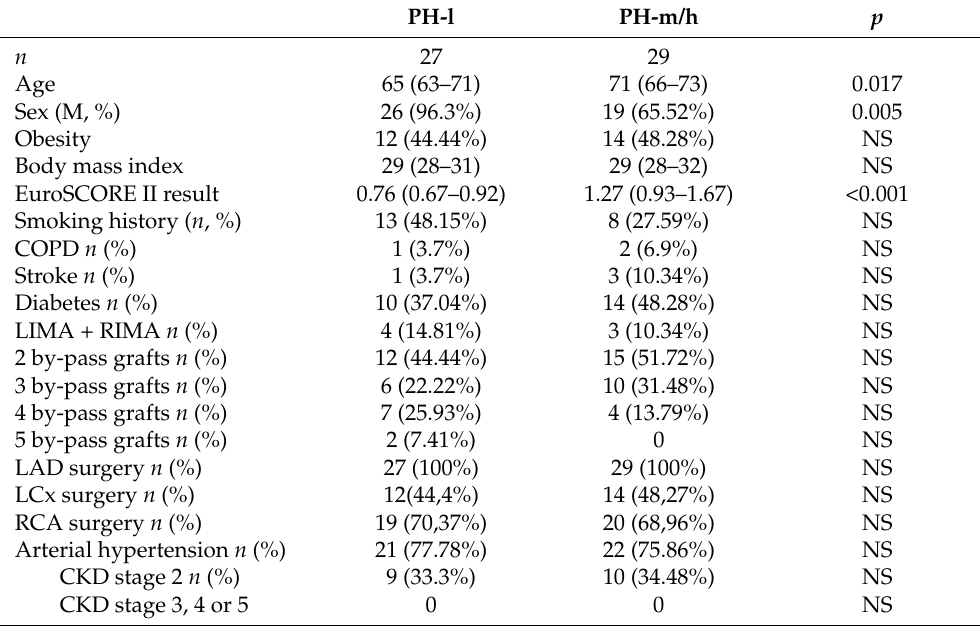
Table 3. Preoperative characteristics of patients and type of